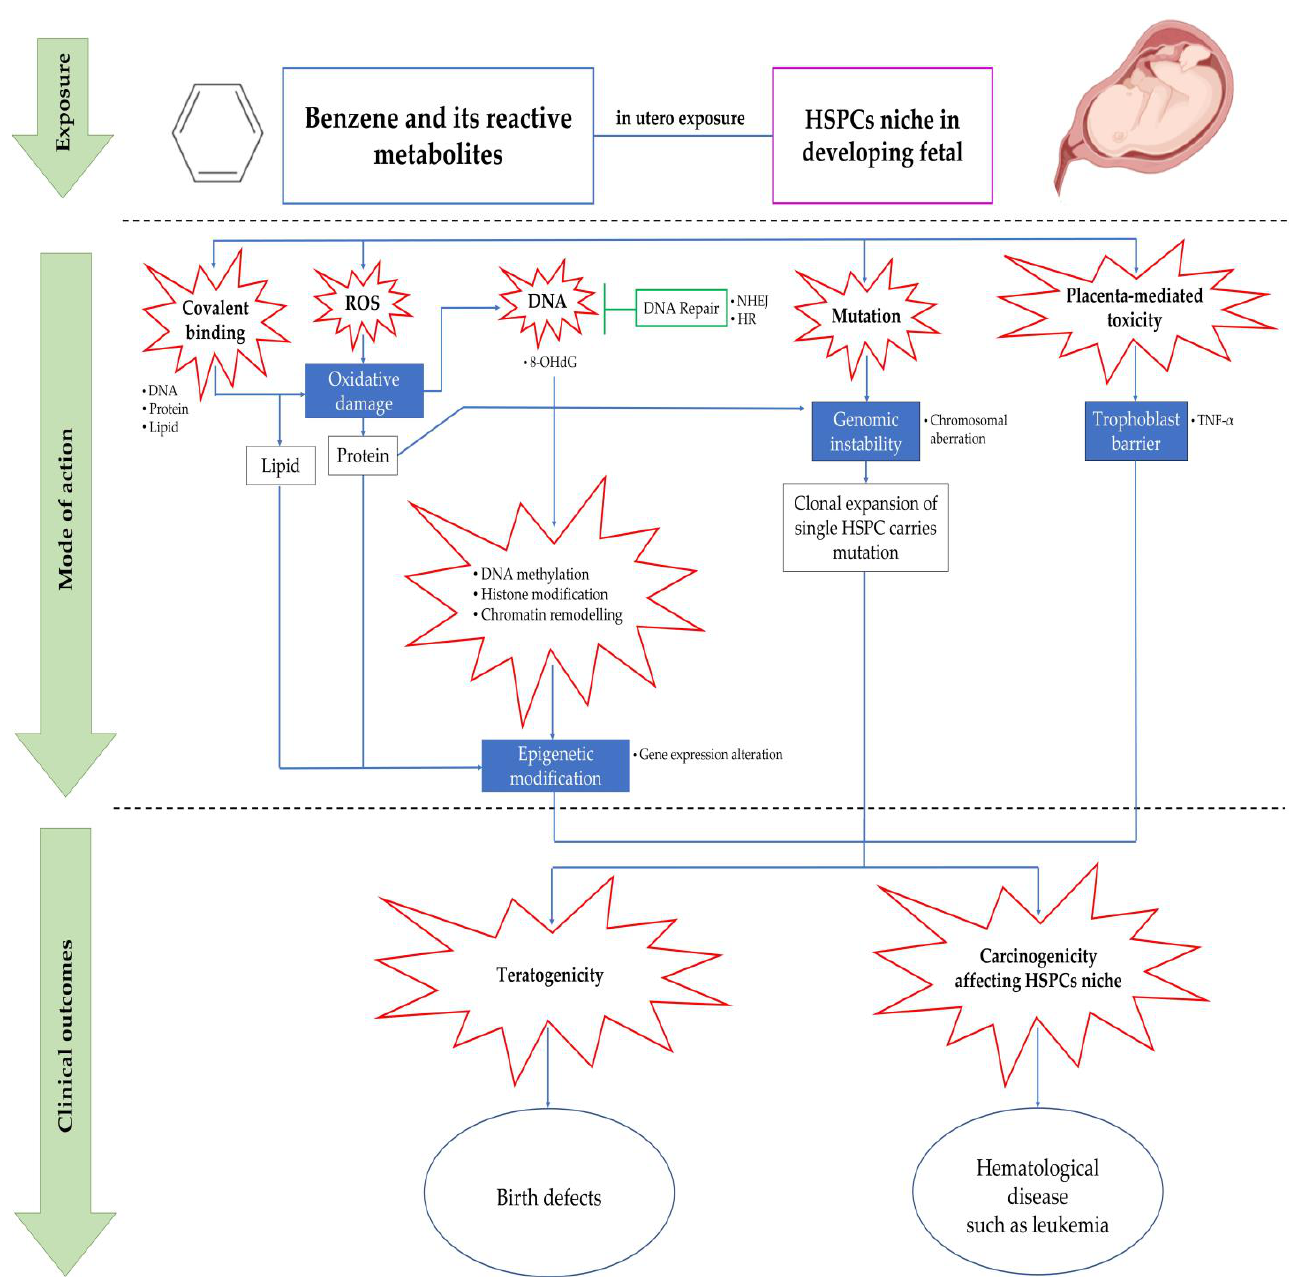
Figure 2. In utero exposure, mode of action and clinical outcomes of benzene and its metabolites on HSPCs niche in developing fetal. Abbreviations: DNA: deoxyribonucleic acid; HR: homologous recombination; 8-OHdG: 8-hydroxy-2 (cid:48) -deoxyguanosine; mEH: microsomal epoxide hydrolase; NHEJ: non-homologous end-joining; ROS: reactive oxygen species; TNF- α : Tumor Necrosis Factor